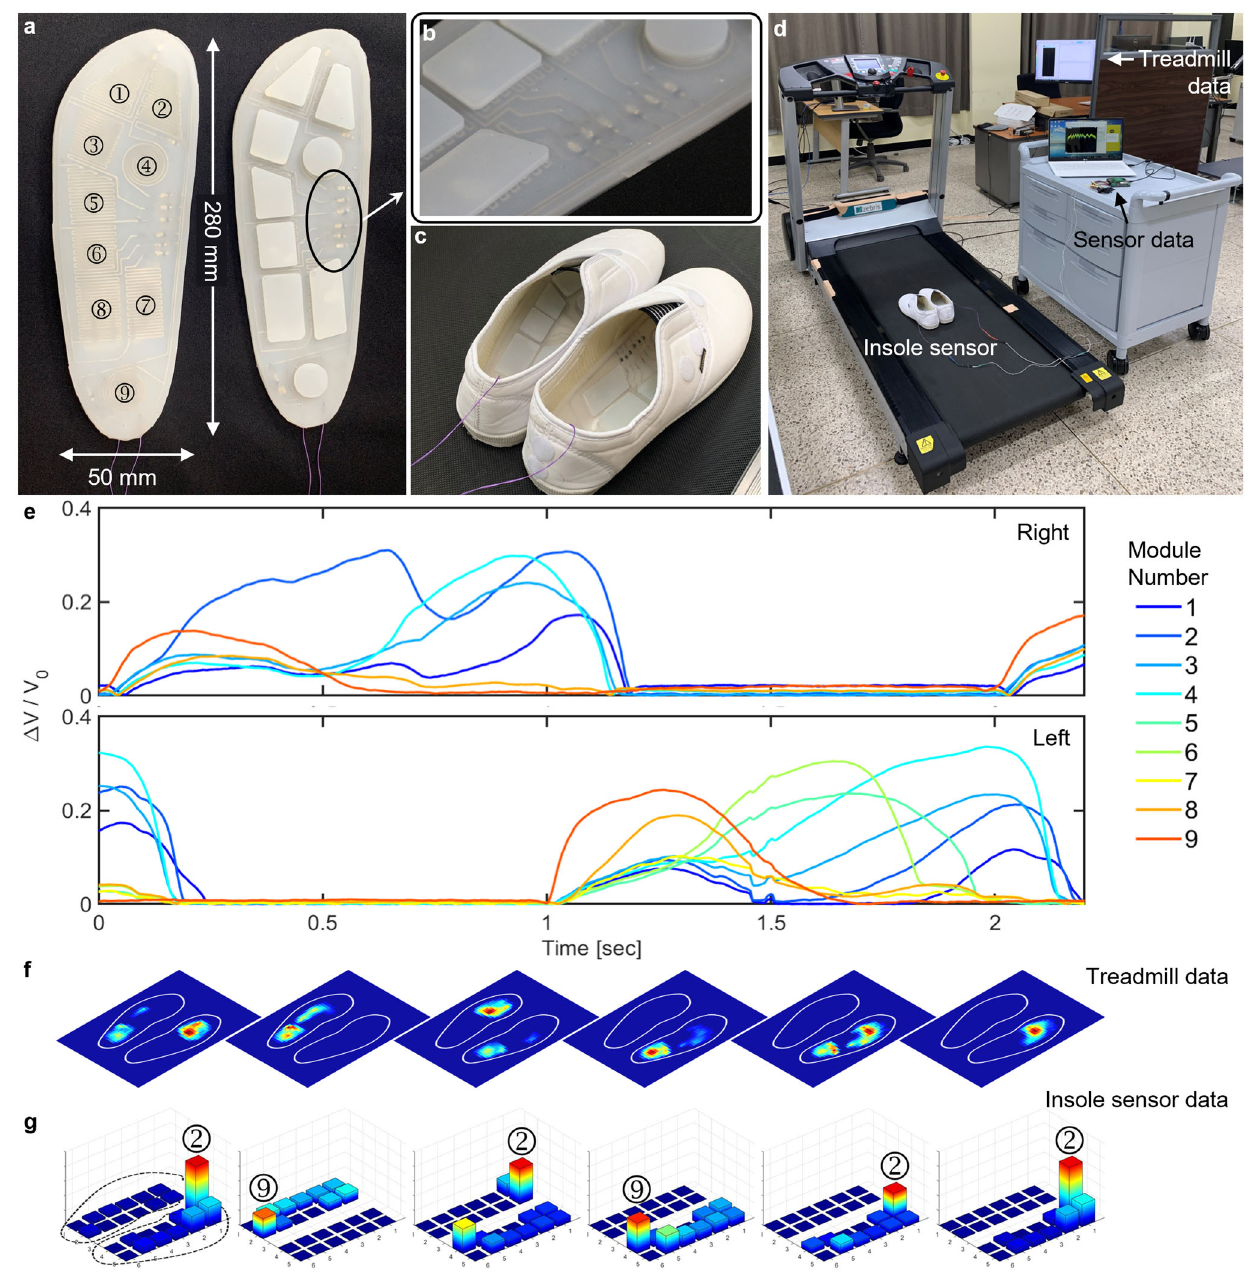
Fig. 4 Insole sensor experiment and result. a Bottom and top views of the insole sensor with the module numbers and the dimensions. b Experimental setup for the insole sensor consisting of a commercial treadmill and a monitoring system. c Closed-up photo of the electronics in the insole sensor. d Shoes equipped with the insole sensors for the experiment. e Insole sensor data acquired during a gait cycle. f Visualization of the pressure distribution measured by the pressure sensing belt in the treadmill and g the corresponding visual presentation of the measured pressure pro fi les by the insole sensor for